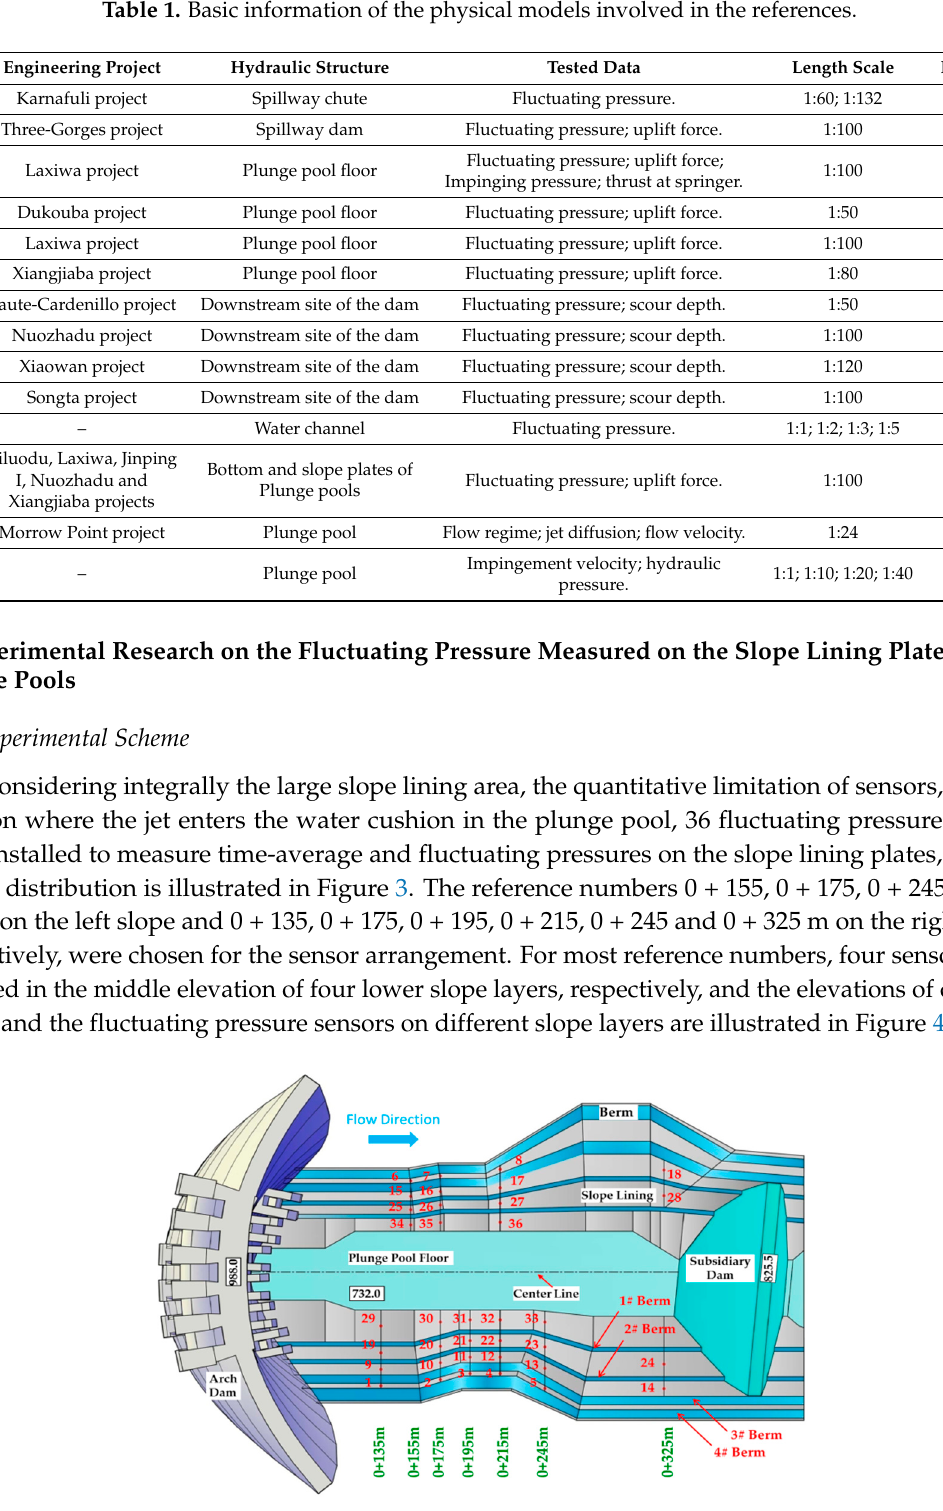
Figure 4. Elevations of berms and sensors on different slope layers. The constitution of the pressure sensors and its manufacturer, type, precision, and other detailed performance parameters are given in Figure 5. Moreover, an electromagnetic flowmeter and a homemade rectangular thin-plate weir were installed in the water inlet and the downstream discharge channel, respectively, of the physical model to measure the discharge of the physical model. The precision of the electromagnetic flowmeter was approximately 6.9 × 10 − 4 m 3 /s, and the values of the flow rates obtained from the two aforementioned instruments were very close to each other. Manufacturer: China Institute of Water Resources and Hydropower Research Sensor type: Silicon piezo-resistive sensor Precision: 0.01 kPa Measurement error: ≤ ±0.5% F.S. Full-scale (F.S.): 0–30 kPa Acquisition frequency: 200 Hz Acquisition time: 100 s ( a ) ( b ) ( c ) Figure 5. Constitution and performance parameters for the pressure sensor. ( a ) sensor components; ( b ) actual photograph; and ( c ) performance parameters.